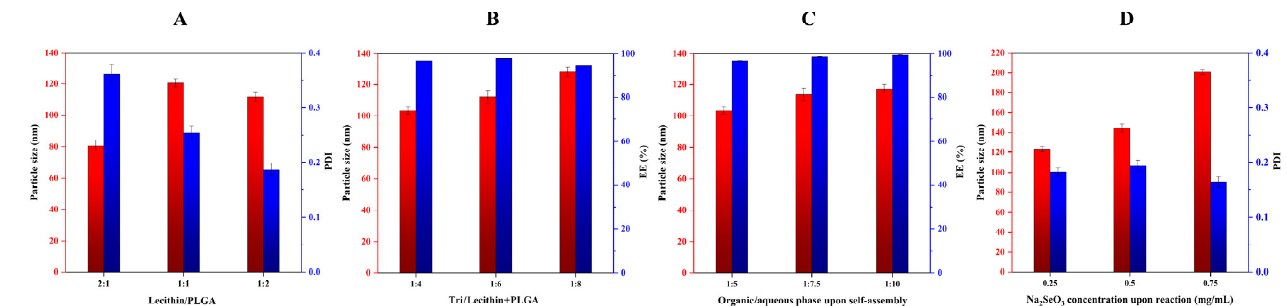
Figure 2. Formulation factors affecting the particle size, polydispersity index (PDI), and entrapment efficiency ( EE ) of nanoparticles: ( A ) mass ratio of lecithin to PLGA; ( B ) mass ratio of Tri/carrier materials (lecithin + PLGA); ( C ) phase ratio of organic to aqueous ( v / v ); and ( D ) Na 2 SeO 3 concentration upon in situ reduction.